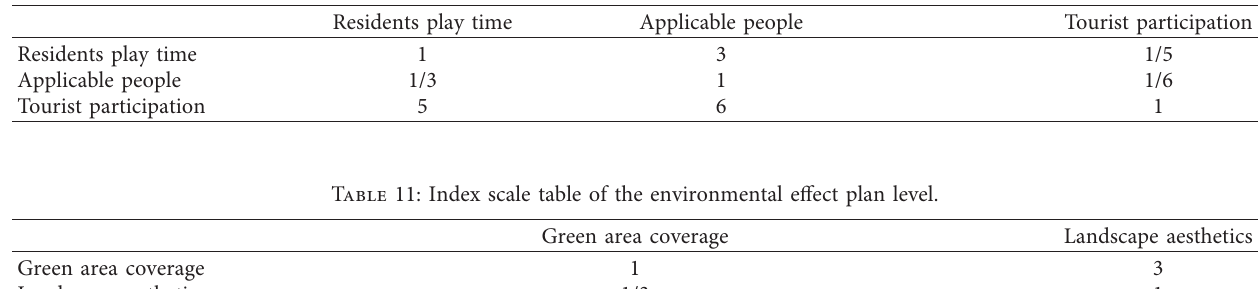
Table 10: Scale table of social effect plan level indicators.